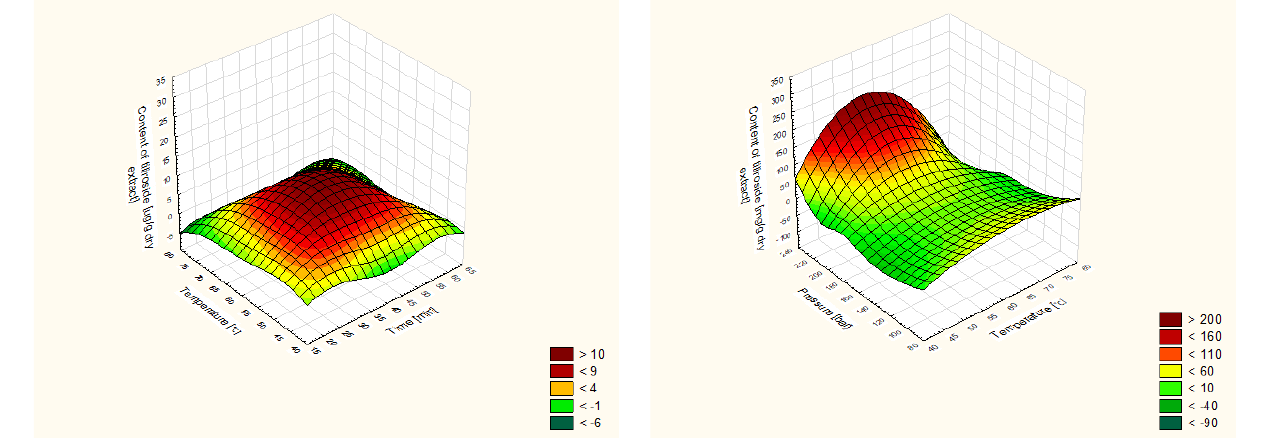
Figure 3: Surface chart 3W of the content of tiliroside vs. temperature and time of extraction (for 5% ethanol concentration) (Smoothing of smallest squares weighted by distance).